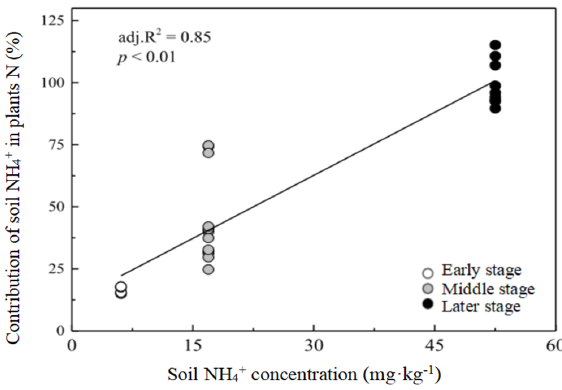
Figure 4. The relationships between soil NH 4+ concentration (mg · kg − 1 ) and the proportional contri- bution (%) of soil NH 4+ in dominant plants N during primary succession. R 2 denotes the proportion of variance explained .